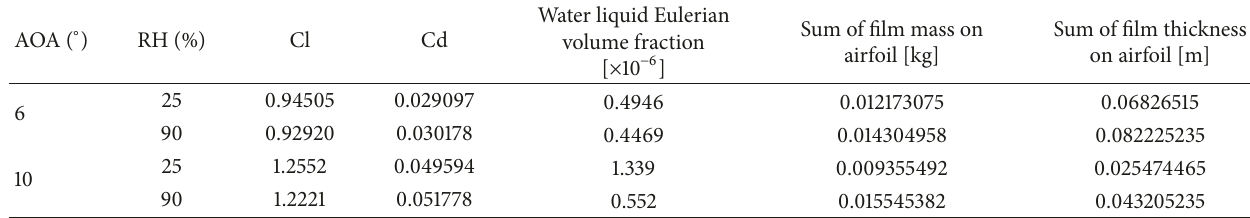
Table 4: Value of EWF model on 1200 steps.